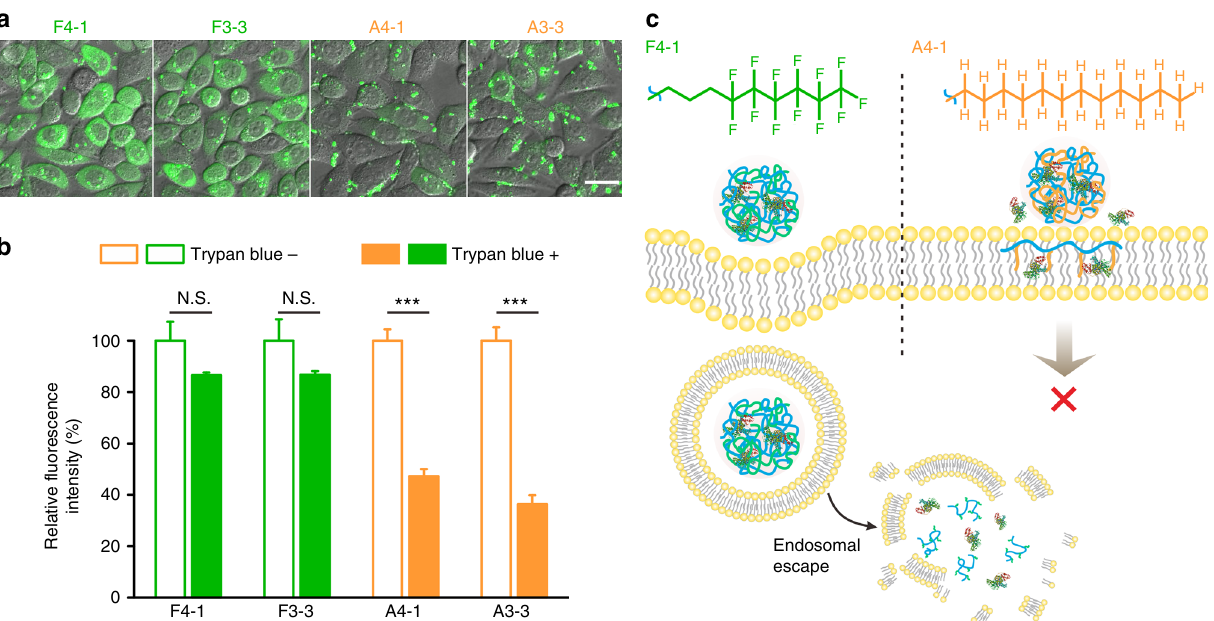
Fig. 2 Fluoroamphiphiles vs. non- fl uorinated controls. a Confocal images of HeLa cells treated with polymer/BSA-FITC complexes for 4 h. The polymers were used at optimal doses listed in Supplementary Table 1. The scale bar is 25 μ m. b Relative fl uorescence intensity of cells in a before and after trypan blue quenching. The fl uorescence intensity of cells treated without trypan blue was de fi ned as 100%. Data are presented as mean ± s.e.m. ( n = 3). N.S. p > 0.05 and *** p < 0.001 analyzed by Student ’ s t -test, one tailed. c Proposed mechanisms of F4-1 and A4-1 in cytosolic protein delivery